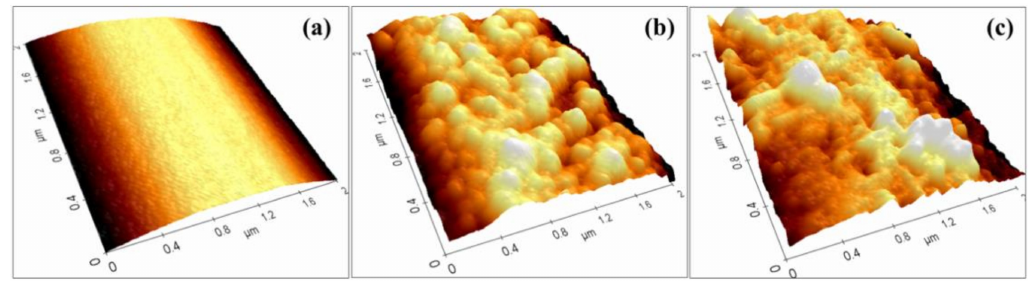
Figure 7. AFM images of PET filaments: ( a ) PF, ( b ) PF-1, ( c ) PF-2.